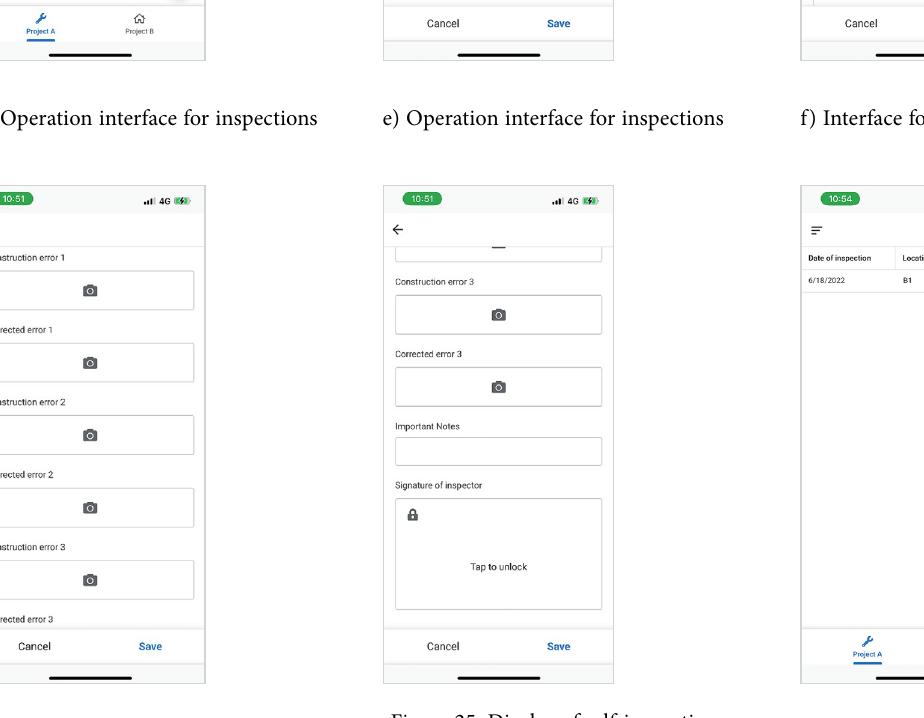
Figure 25. Display of self-inspection